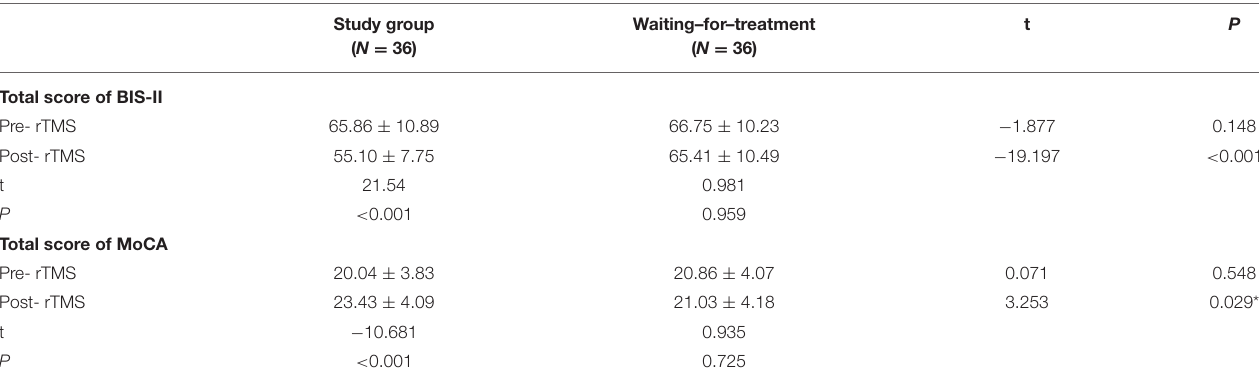
TABLE 3 | Pre-post comparison of BIS-II, MoCA after rTMS.